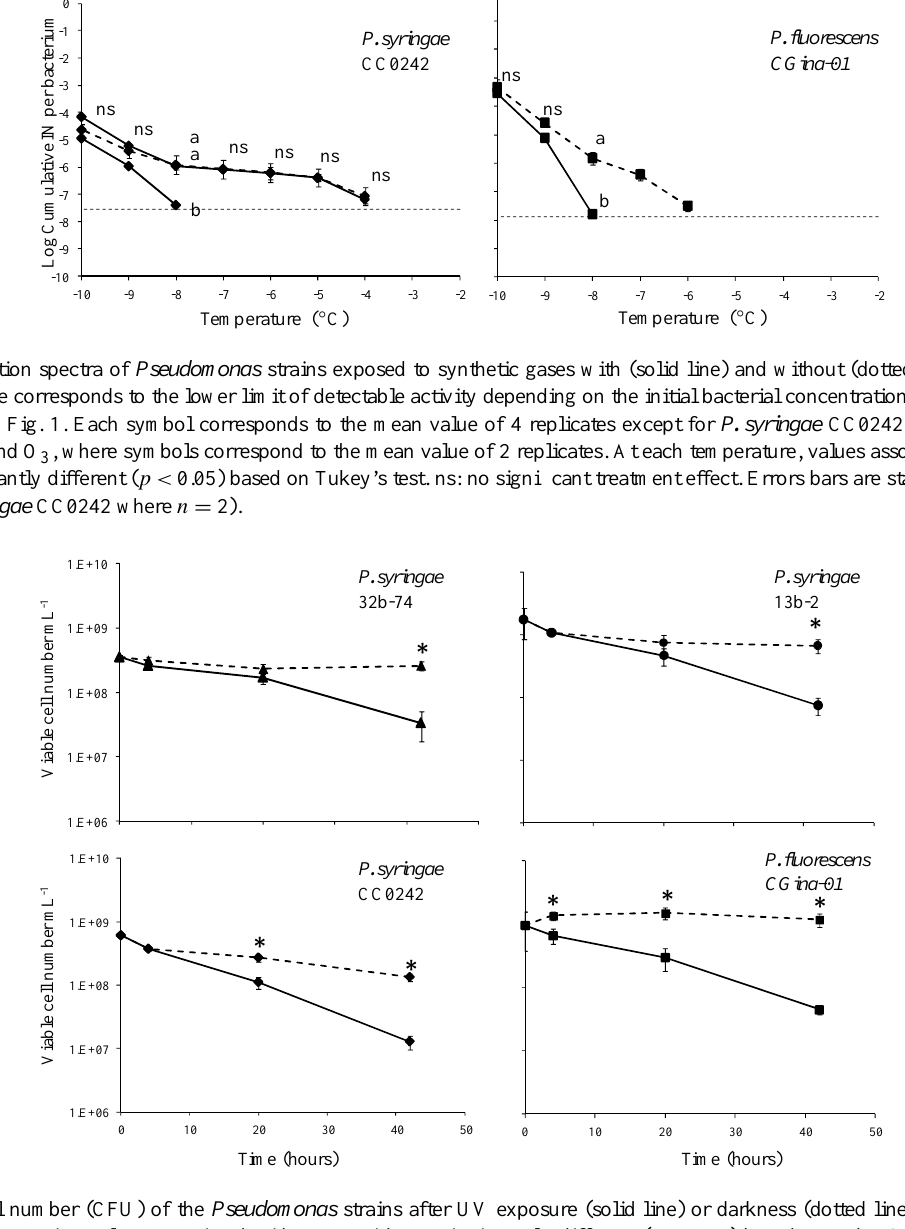
Fig. 4. Viable cell number (CFU) of the Pseudomonas strains after UV exposure (solid line) or darkness (dotted line). Symbols are as in Fig. 1. At each time point, values associated with an asterisk are significantly different ( p < 0.05) based on Tukey’s test. Errors bars are Figure 4: Viable cell number (CFU) of the Pseudomonas strains after UV exposure (solid 3 standard errors ( n = line) or darkness (dotted line). Symbols are as in Figure 1. At each time point, values 4 associated with an asterisk are significantly different (p<0.05) based on Tukey’s test. Errors 5 bars are standard errors (n=4). 6